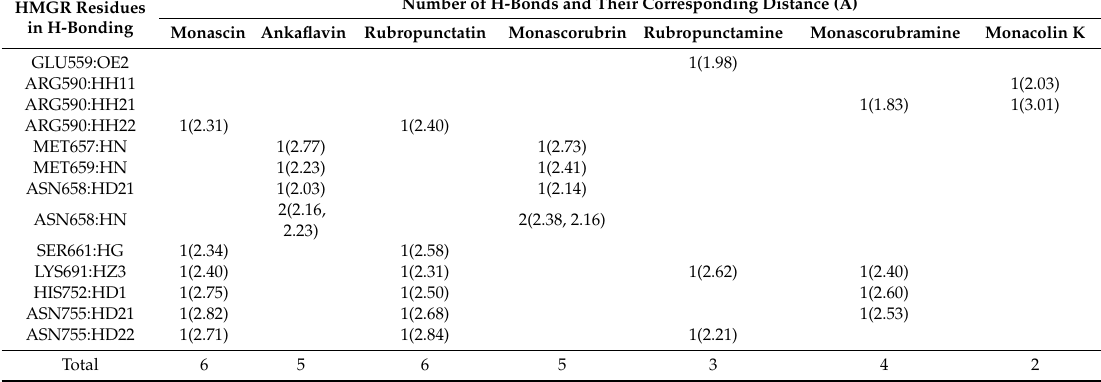
Table 4. Hydrogen bonds observed in the best scored docking model of the six main MPs and Monacolin K within HMGR (PDB: 1HW9).